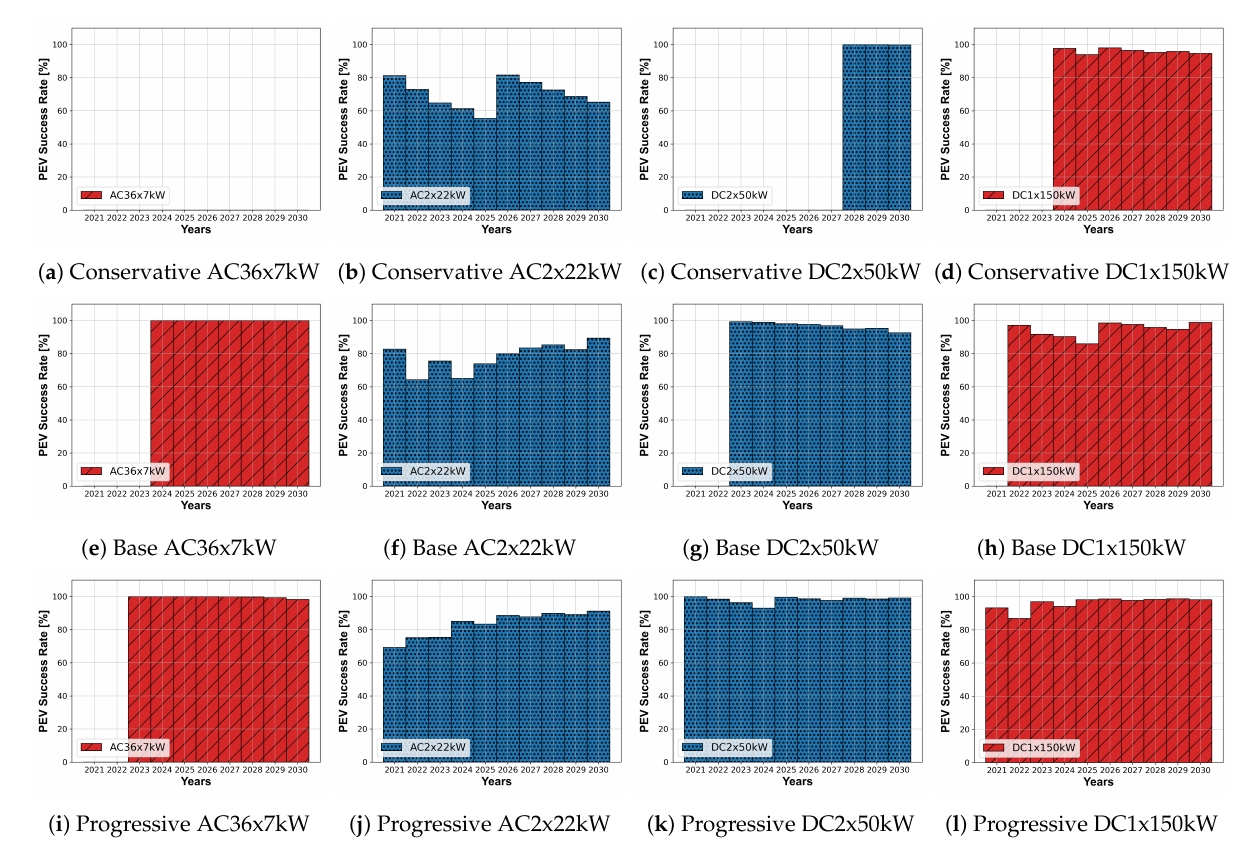
Figure A4. Success Rate to occupy a free Charging Point of the Charging